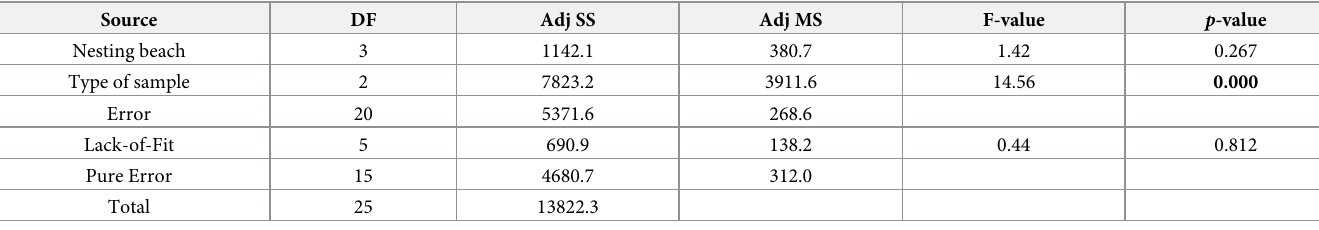
Table 2. Two-way ANOVA demonstrated that type of sample affected microbial